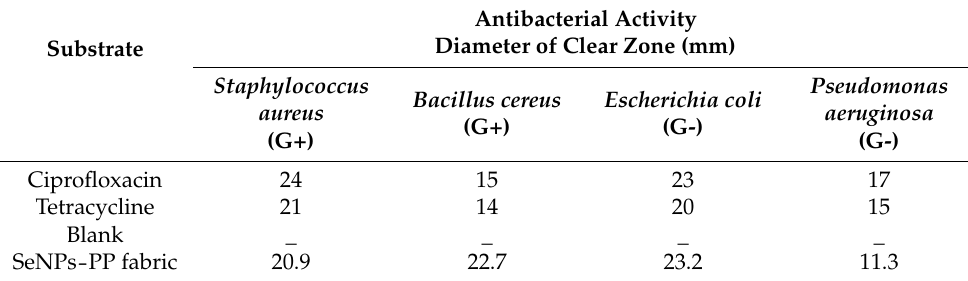
Table 3. Clear zone (mm) of the PP and SeNPs-PP